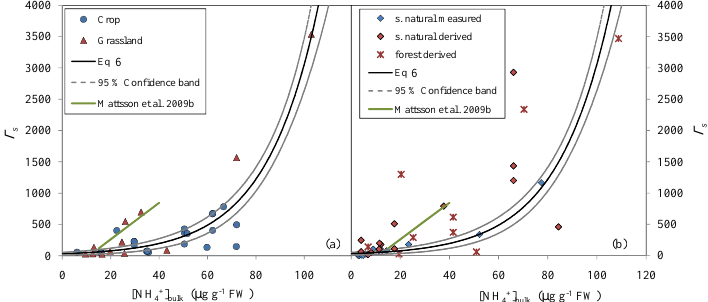
Fig. 4. (a) Compiled stomatal ammonia emission potential ( 0 s ) for managed ecosystem types as a function of measured bulk tissue [NH + ] bulk concentrations. Round symbols represent arable crops and triangle symbols represent grasslands. The black line is the best 4 fit exponential curve derived by minimisation of the least square method and the dashed line is the 95% confidence band. The green line is the linear function previously derived by Mattsson et al. (2009b) between 0 s and [NH + stomatal ammonia emission potential ( 0 s ) for un-managed ecosystem types as a function of bulk tissue [NH + symbols represent [NH + ] bulk derived from N deposition values according to Eq. (7) while blue symbols represent measured concentrations. 4 Asterisks represent forests and diamonds represent short semi-natural ecosystem types. The full, dashed and green lines are similar to